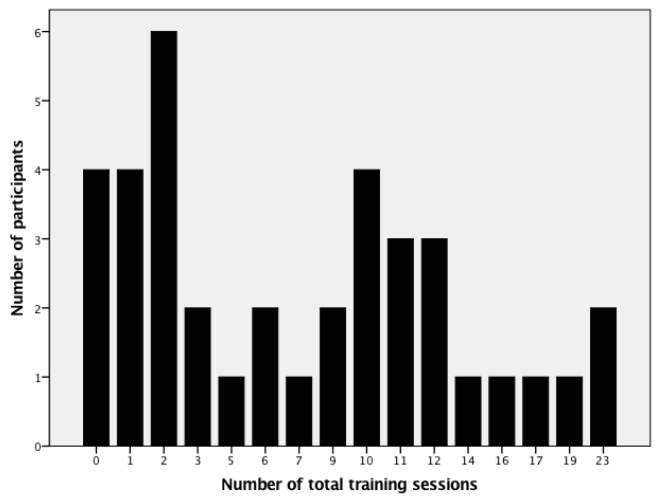
Figure 1. Distribution of total training sessions.